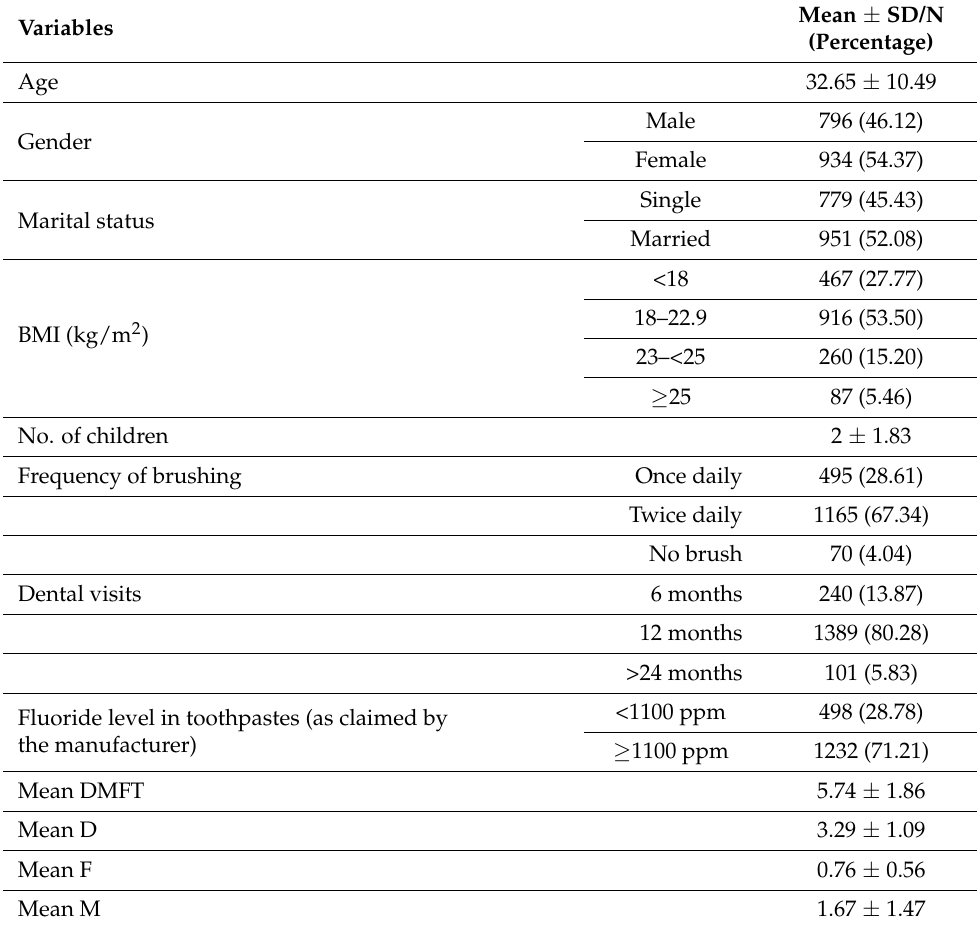
Table 1. Detailed description of study participants ( n =